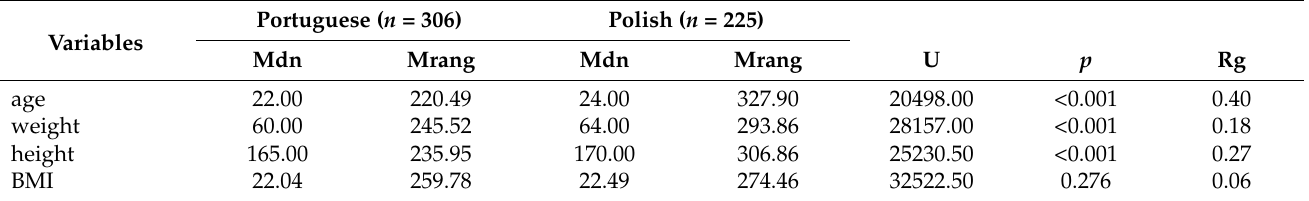
Table 2. Results of analysis using Mann–Whitney U test on demographic variables by nationality.